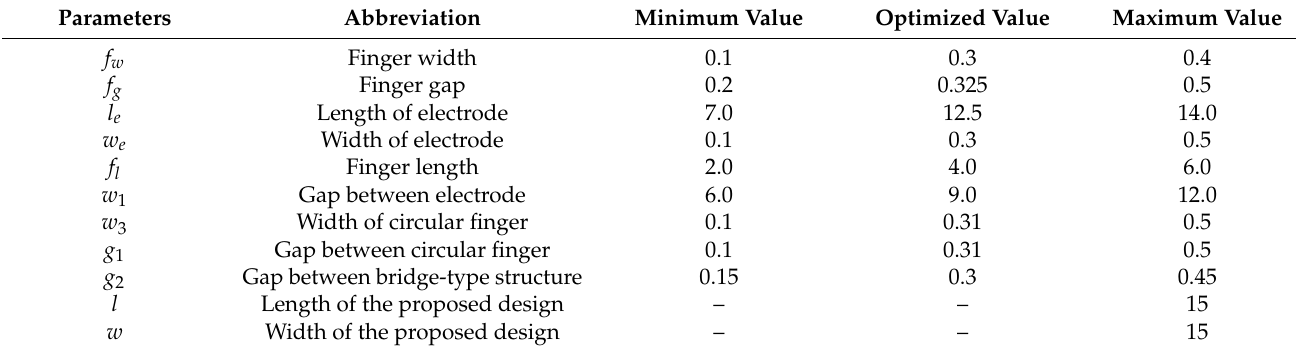
Figure 3. ( a ) Lower tunable resonating frequency of optimized microwave sensor and ( b ) different parameters of the developed sensor. Table 1. Different optimized parameters of the proposed microwave sensor.